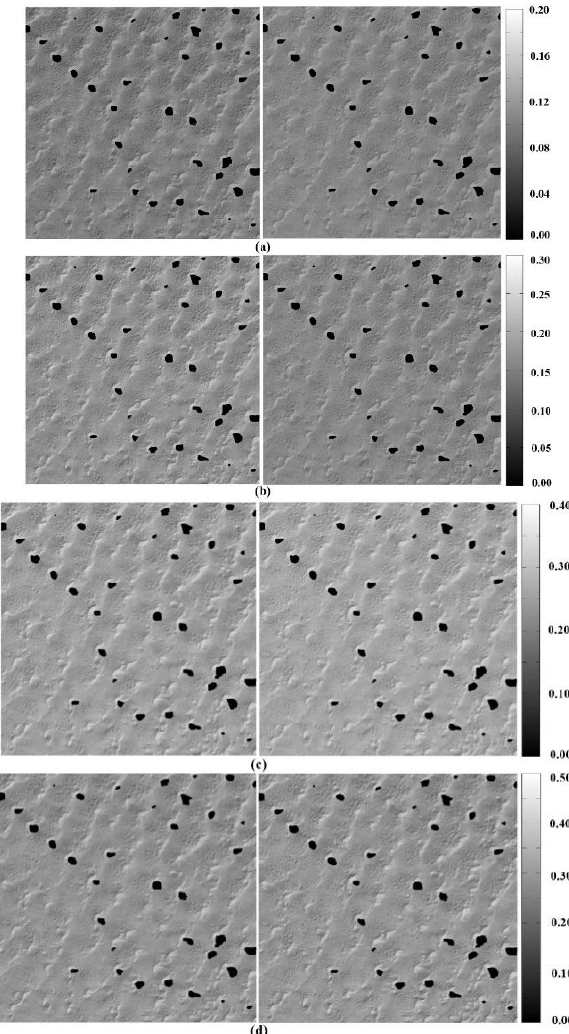
Figure 6. Example of simulated surface reflectance and its corresponding actual surface reflectance. ( a ) Simulated surface reflectance ( left ) and actual surface reflectance ( right ) of band 2. ( b ) Simulated surface reflectance ( left ) and actual surface reflectance ( right ) of band 3. ( c ) Simulated surface reflectance ( left ) and actual surface reflectance ( right ) of band 4. ( d ) Simulated surface reflectance ( left ) and actual surface reflectance ( right ) of band